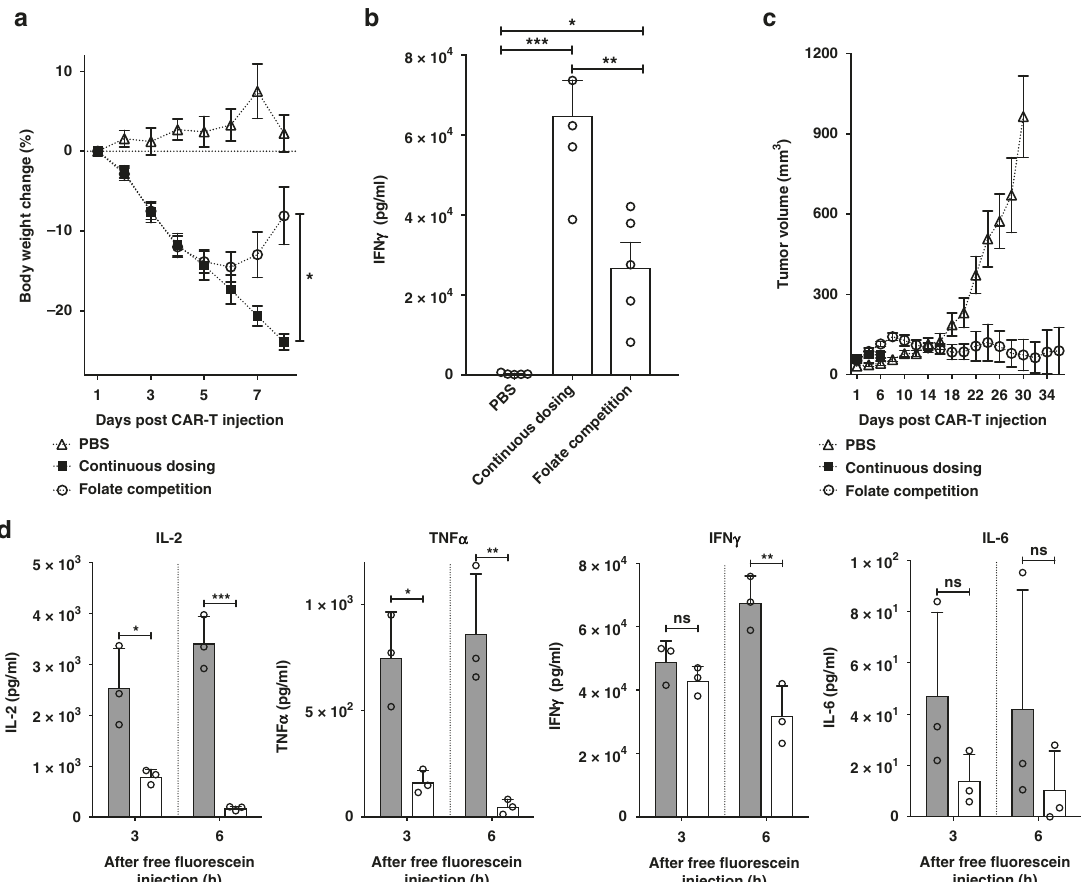
Fig. 5 Effect of blockade of adapter binding via competition with free folate or free fl uorescein on CAR T cell-mediated cytotoxicity. a Measurement of bodyweight change (%) after administration of anti- fl uorescein CAR T cells (15×10 6 ) in the absence (PBS) or presence of FITC-folate (500nmole/kg administered on days 1, and 2, and alternate days thereafter). For competition studies, 100-fold excess folate was co-injected on days 4 and 6. b Analysis on day 6 of IFN γ levels in plasma of above treatment groups. ** P < 0.005. c Measurement of tumor volume in same treatment groups. n = 5 mice per